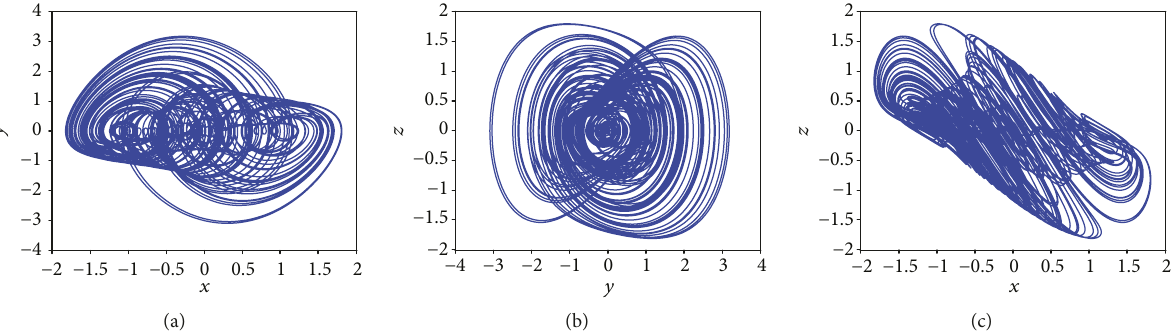
Figure 3: (a) x - y phase portrait, (b) y - x phase portrait, (c) x - z phase portrait.